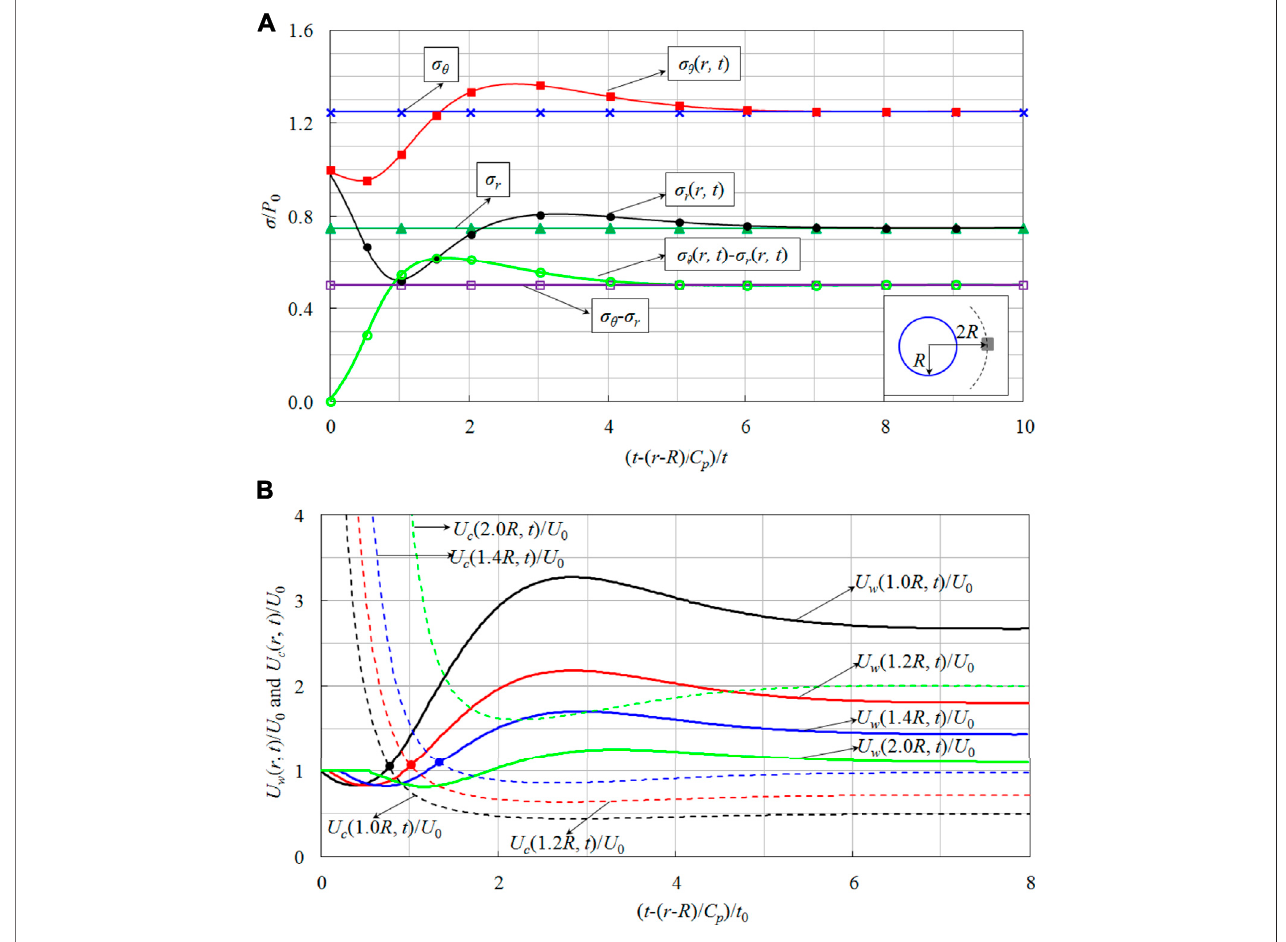
FIGURE 8 | Dynamic response induced by transient unloading of in-situ stress. (A) Dynamic stress of surrounding rock masses induced by transient unloading of in-situ stress ( r (cid:1) 2 R ), (B) Variation process of strain energy density and energy storage limit induced by transient unloading of in-situ stress.